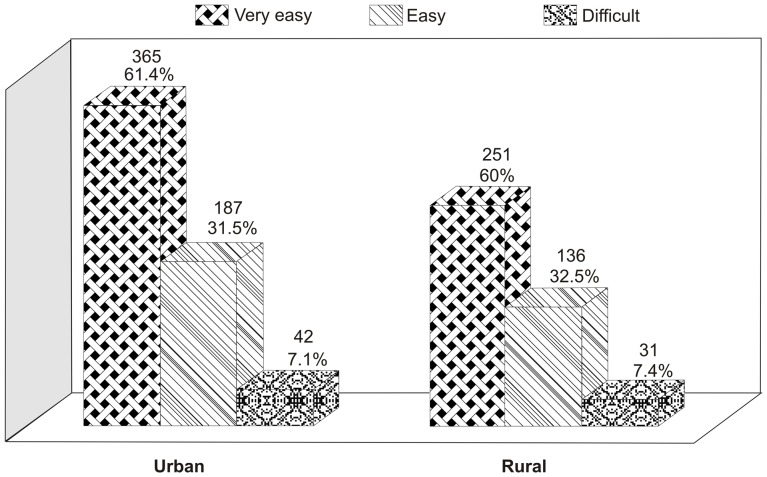
Categorization of Cigarettes Accessibility vs. Lifestyle.